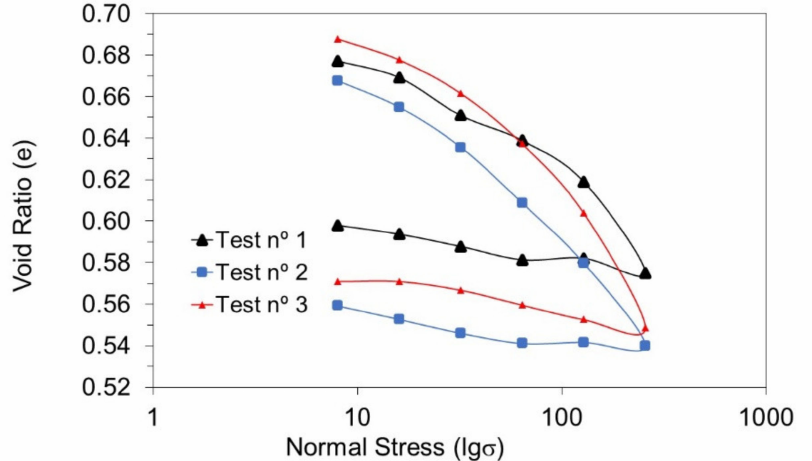
Figure 13. Oedometric curves obtained for the wood pellets in the oedometric assays.